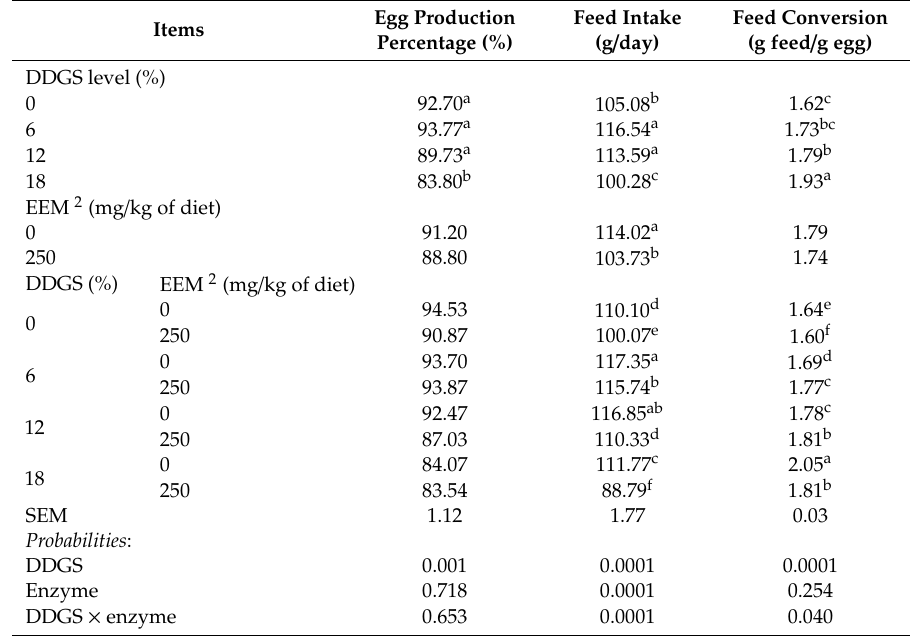
Table2. LayingperformanceofhensorganizedbyDDGS 1 inclusionlevelsandenzymesupplementation through 32–42 weeks of